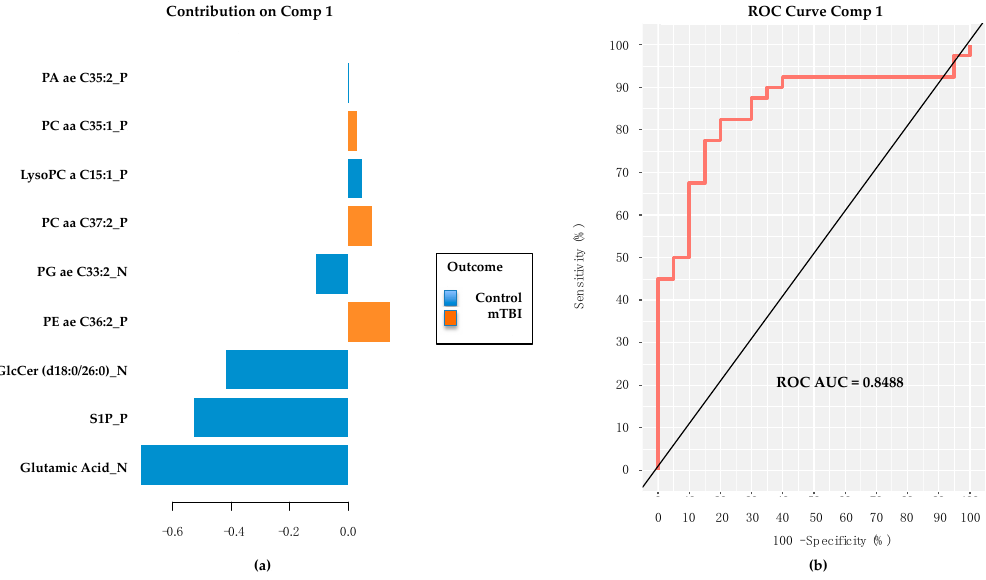
Figure 4. Contribution plot and performance of 9 common subacute TBI biomarkers classifying the PD/PPD subjects from PD controls. ( a ) Note prominence of the Glutamic Acid contribution, but with relative abundance values reduced in PD/PDD and compared to controls. ( b ) Respectable performance (ROC AUC = 0.8488) of 9 member panel in classifying PD/PDD subjects from controls. Comp = PLS-DA model component. TBI = traumatic brain injury. PD = Parkinson’s disease. PDD = PD dementia. ROC AUC = receiver operating characteristic area under the curve. PA = Phosphatidic acid. PC = phosphatidylcholine. LysoPC lysophosphatidylcholine. PG = Phosphatidylglycerol. PE = phosphatidylethanolamine. GlcCer = glucosylceramide. S1P = sphingosine-1-phosphate. Final metabolite identifications will require additional tandem mass spectrometry (MS/MS) analyses. Metabolites confirmed via MS/MS are considered fully validated, to a high degree of confidence.